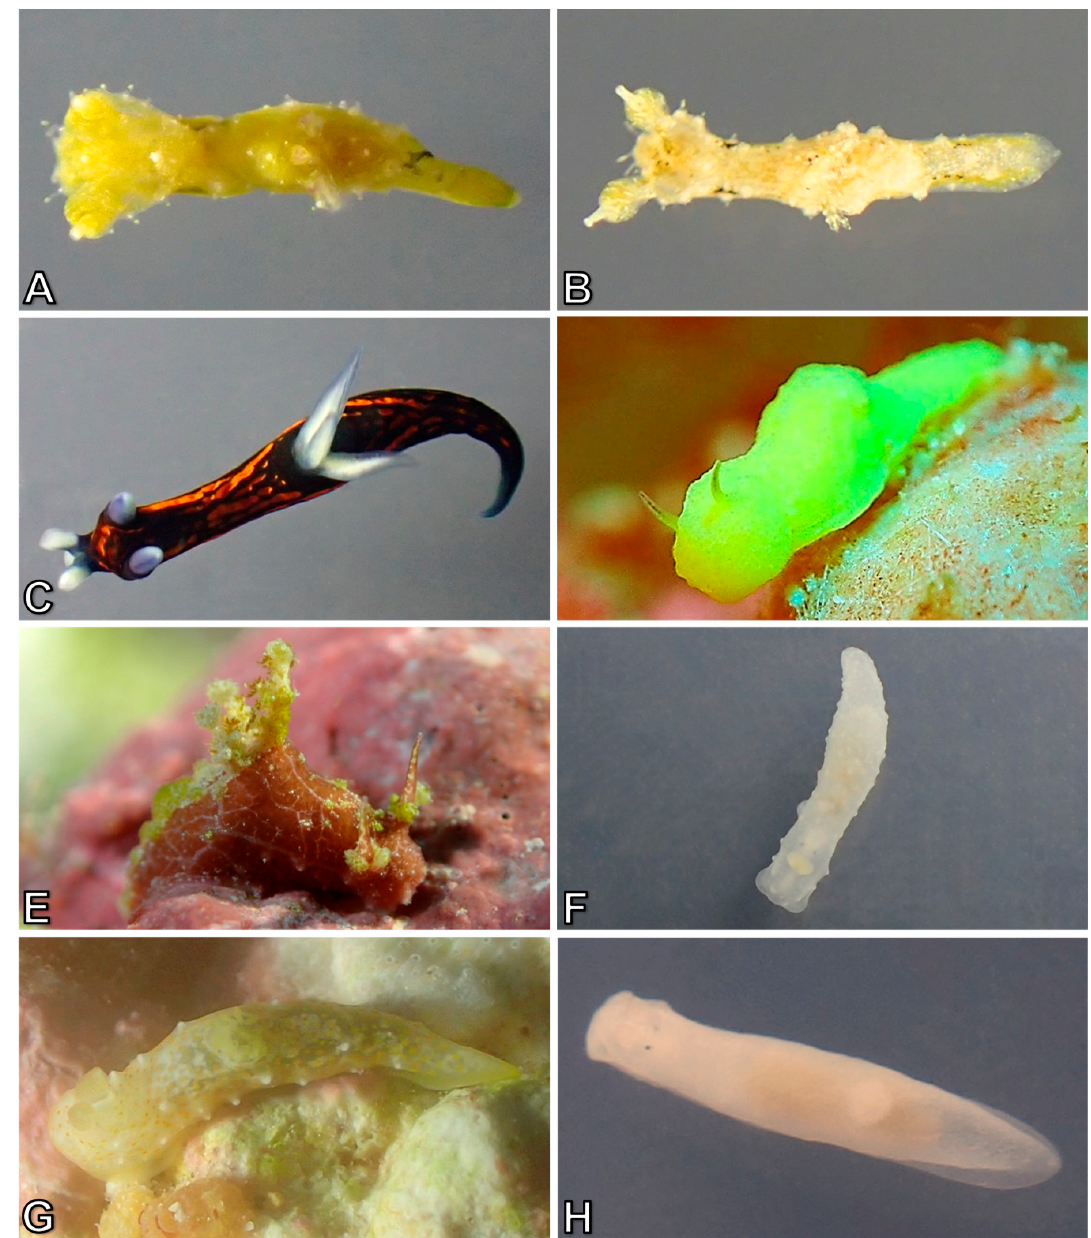
Figure 7. Nudibranchia - Doridina: ( A ) Polycera japonica ; ( B ) Polycera spec. ( Polycera sp. 5 in Gosliner et al. [11]: 113), Posp516Bu-1; ( C ) Roboastra gracilis ; ( D ) Aegires citrinus ; ( E ) Aegires malinus ; ( F ) Gymnodoris tuberculosa ; ( G ) Gymnodoris spec. ( Gymnodoris sp. 2 in Gosliner et al. [11]: 152), Gysp2_16Bu-1; ( H ) Gymnodoris spec. ( Gymnodoris cf. sp. 35 in Gosliner et al. [11]: 159), Gysp16Bu-1.